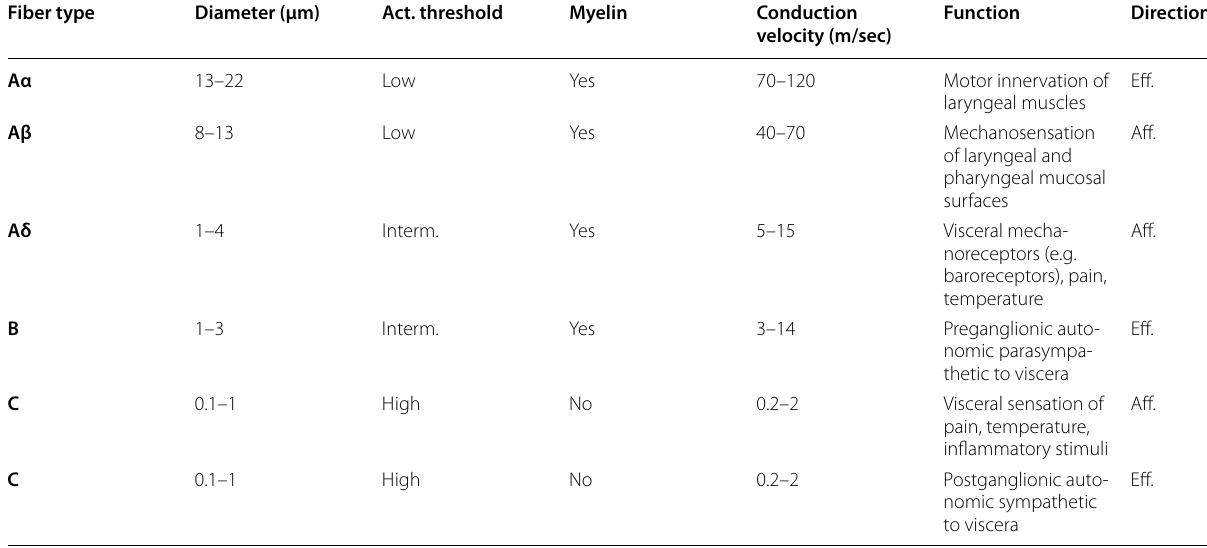
Table 1 Classification of vagal fiber types at the cervical level according to the Erlanger‑Gasser scheme Fiber